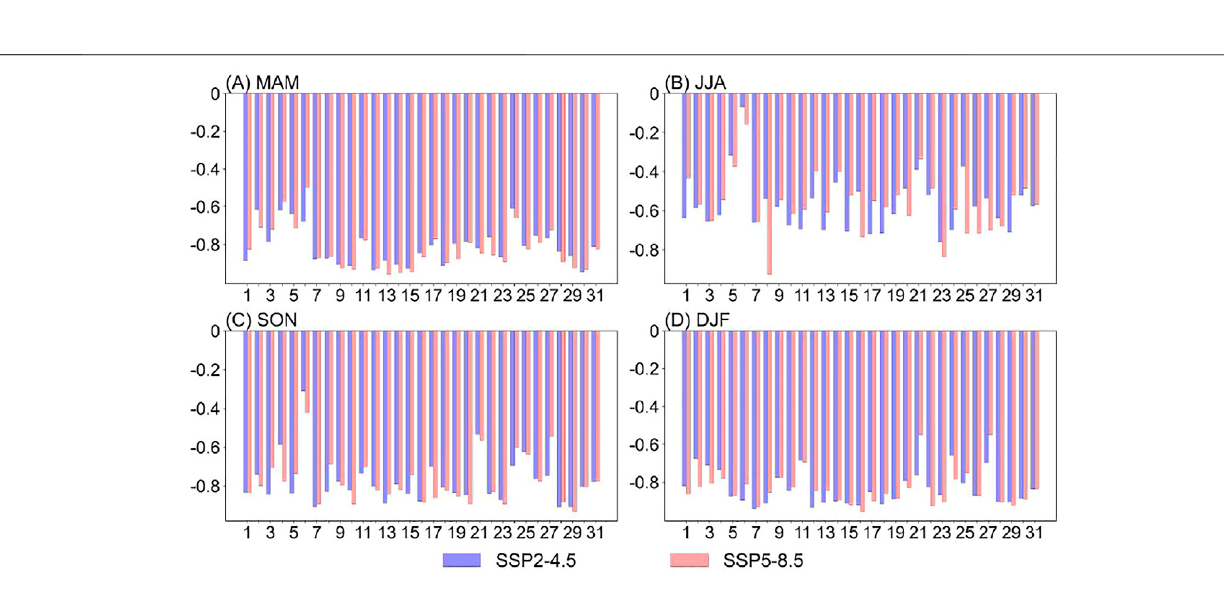
Frontiers in Earth Science |